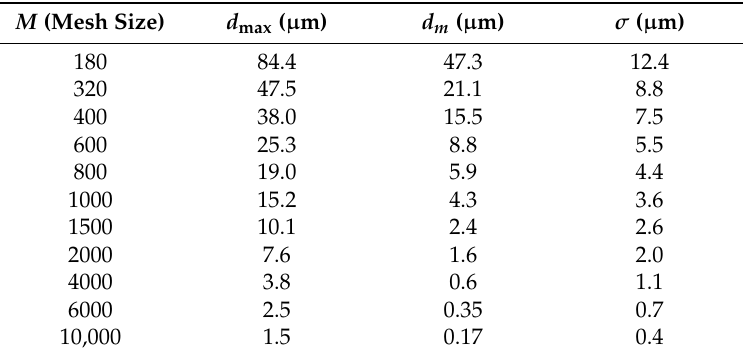
Table 1. Values of d m , d max and σ for different grit